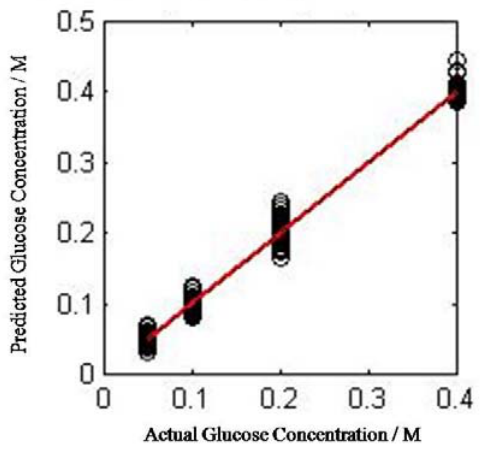
Figure 5. The correlation coefficient between the actual and predicted glucose